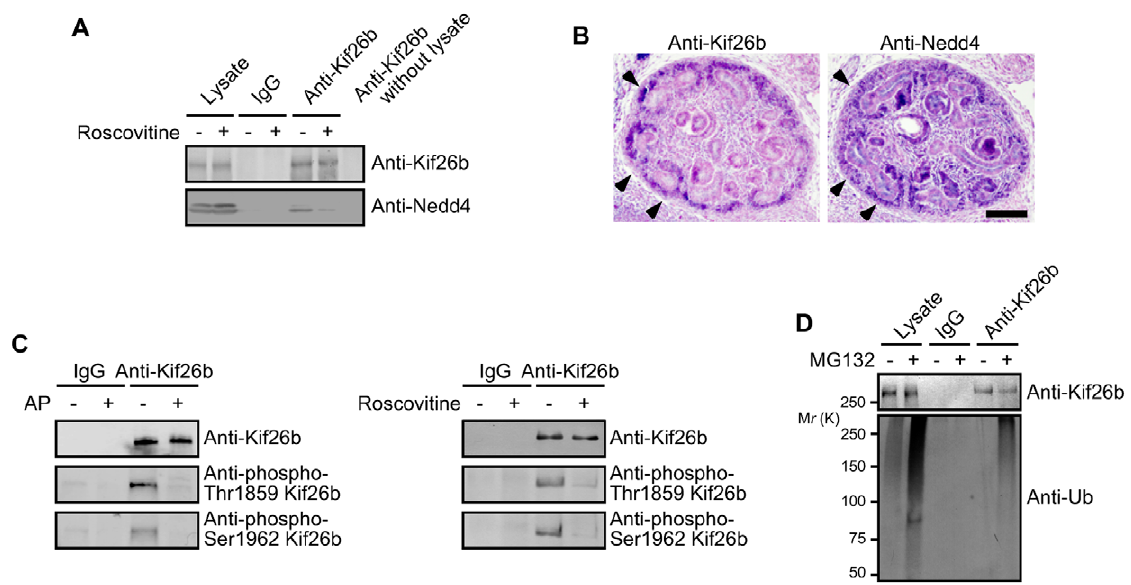
Figure 7. Phosphorylation and polyubiquitination of Kif26b in the developing kidney. A . E14.5 kidneys were cultured in vitro for 8 h with or without roscovitine (20 m M) (indicated as ‘‘ + ’’ or ‘‘ 2 ,’’ respectively). Kif26b was immunoprecipitated from the lysates with anti-Kif26b antibody and subjected to immunoblotting with the indicated antibodies. Immunoprecipitations with rabbit IgG and without lysate were performed as controls. B . Kidneys dissected from E14.5 embryos were stained with the indicated antibodies. Arrow heads indicate the metanephric mesenchyme. Scale bar=10 m m. C. Kif26b was immunoprecipitated from E14.5 kidney lysates with anti-Kif26b antibody, and precipitates were treated with or without AP for 1 h at 37 u C and analyzed by immunoblotting with the indicated antibodies (left panel). E14.5 kidneys were cultured in vitro for 8 h with or without roscovitine (20 m M) (indicated as ‘‘ + ’’ or ‘‘ 2 ,’’ respectively). Kif26b was immunoprecipitated and subjected to immunoblotting with the indicated antibodies (right panel). D. E14.5 kidneys were cultured in vitro for 8 h with or without MG132 (20 m M) (indicated as ‘‘ + ’’ or ‘‘ 2 ,’’ respectively). Kif26b was immunoprecipitated from the lysates with anti-Kif26b antibody and subjected to immunoblotting with the indicated antibodies.